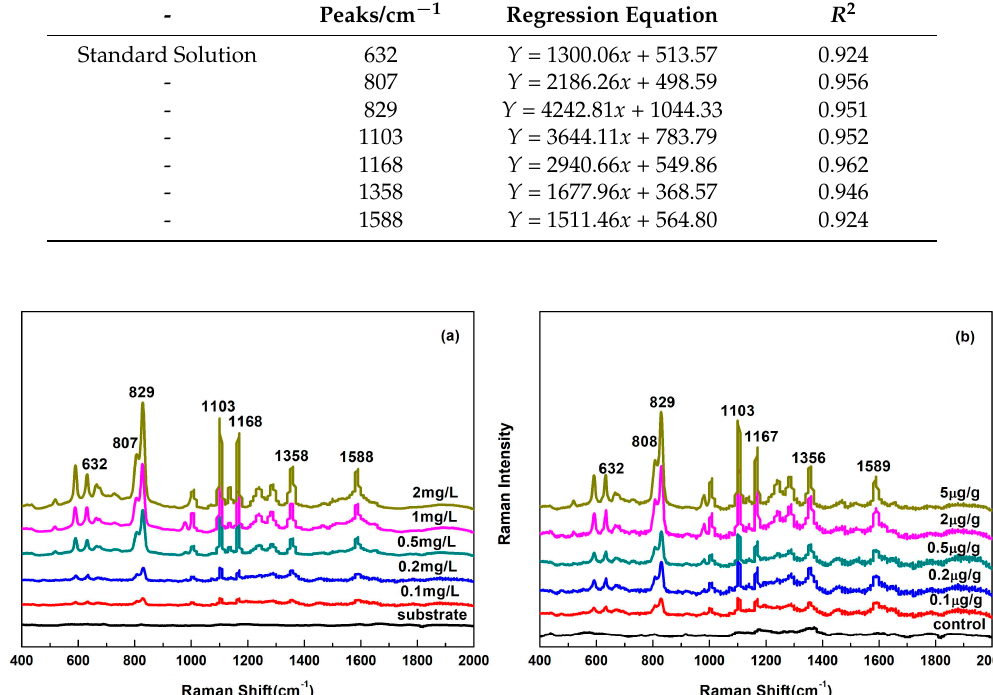
Figure 5. SERS spectra of ( a ) flusilazole standard solutions and ( b ) flusilazole polluted pear extracts.